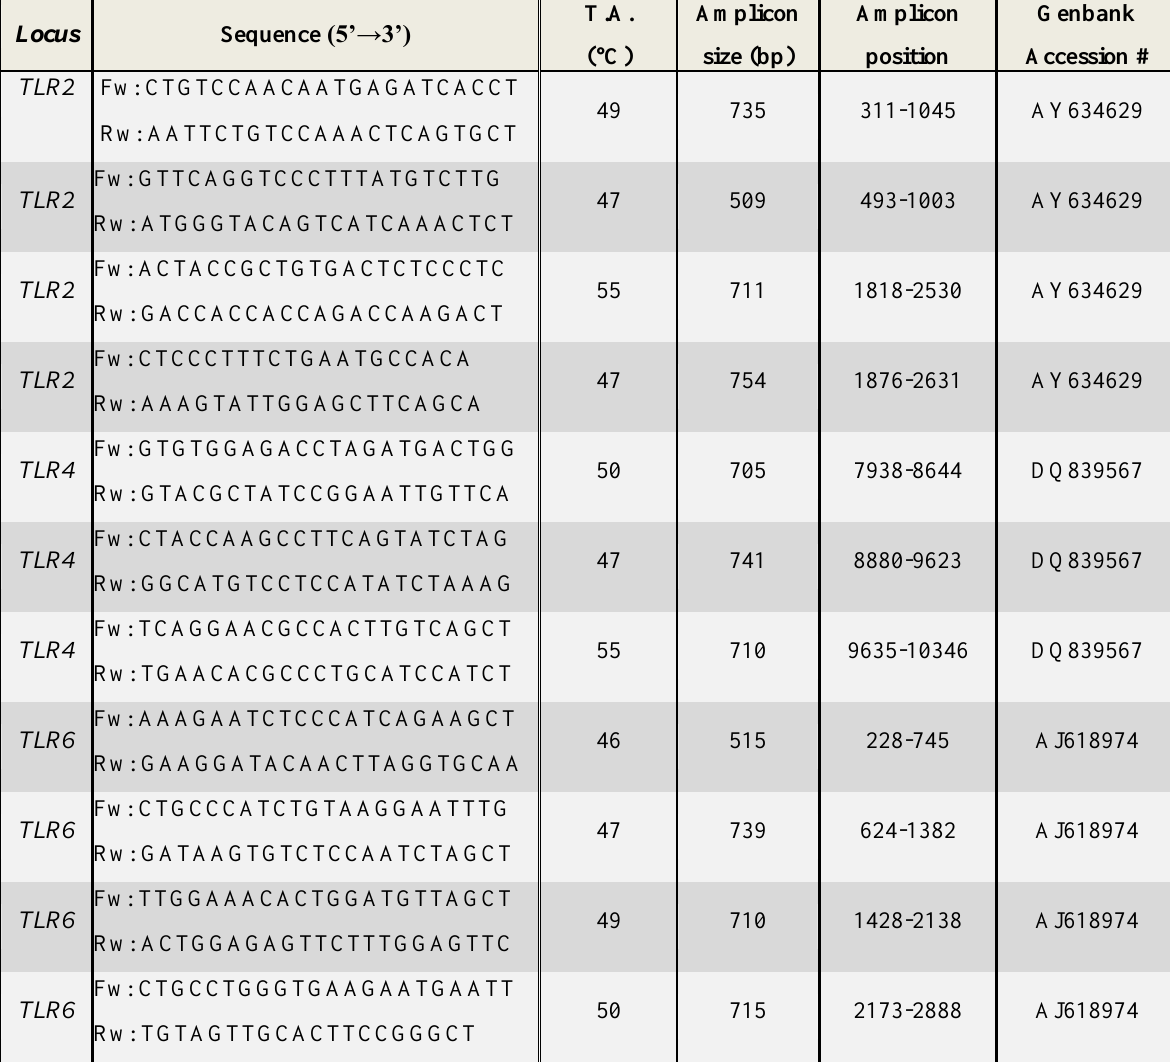
Table 1. Sequence of Forward (Fw) and Reverse (Rw) primers, annealing temperature (T.A.), amplicon size and amplicon position relatively to Genbank sequences. Locus Sequence